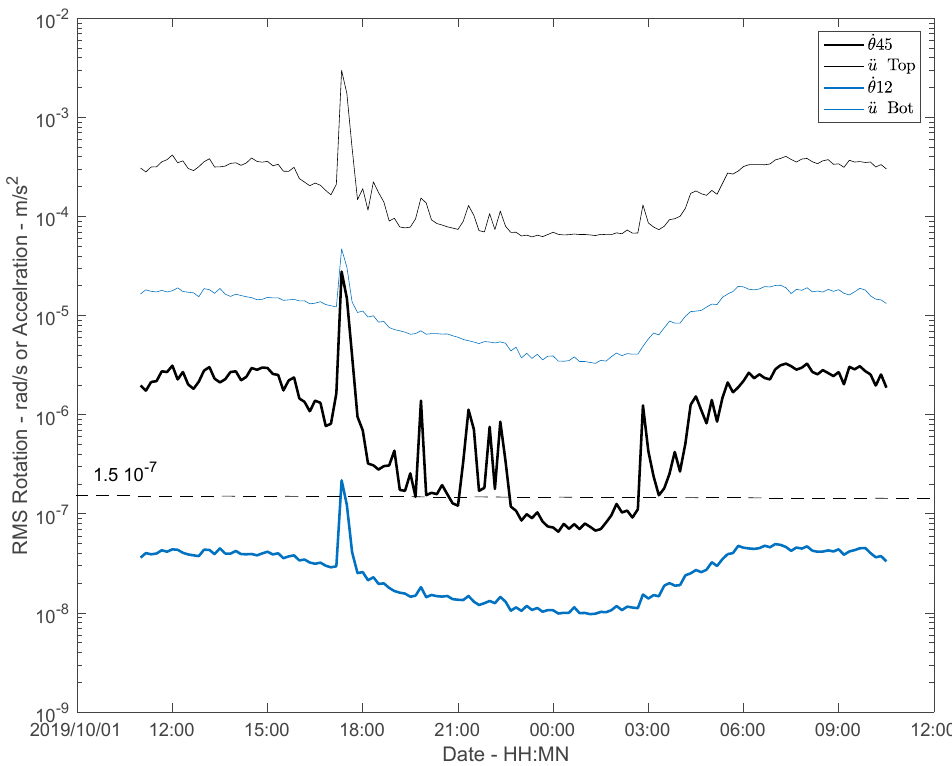
Figure 8. Amplitude variation of the RMS values of translation and array-derived rotations during the experiment, at the top and at the bottom of the structure. The dashed horizontal line corresponds to the sensitivity limit of the rotation sensor, estimated experimentally.